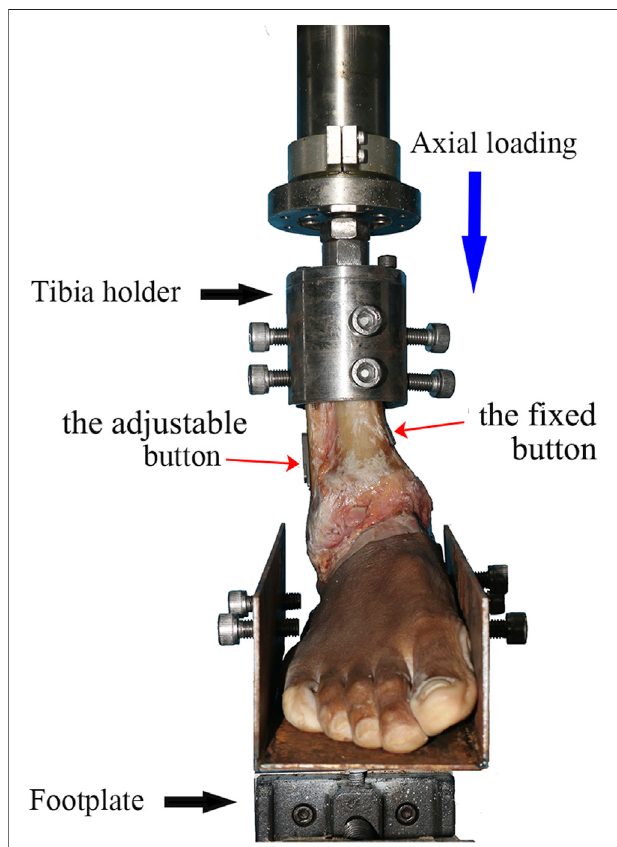
FIGURE 5 | Specimen mounted on the biomechanical testing equipment. Axial and torsional loading experiments were conducted on the equipment.The NAEwasinserted intothetibio fi bularsyndesmosis(shownby the red arrows).